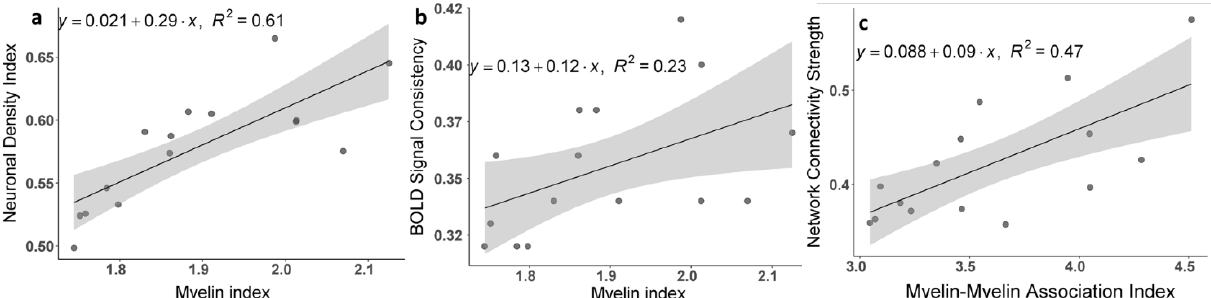
Figure 5. Association between qGRE and T1w/T2w results based on 15 networks. ( a ) Correlation between the Neuronal Density Index and Myelin Index. Points represent average values for individual networks. Shaded areas indicate 95% confidence intervals. The Myelin Index was calculated based on T1w/T2w images. ( b ) Correlations between the strength of the BOLD signal coherence and average Myelin Index in the networks. ( c ) Correlation between the resting-state intra- network connectivity strength, NCS, and Myelin – Myelin Association Index calculated based on the myelin indices in the connected ROIs (similar to that described by Equations (4) and (8)).